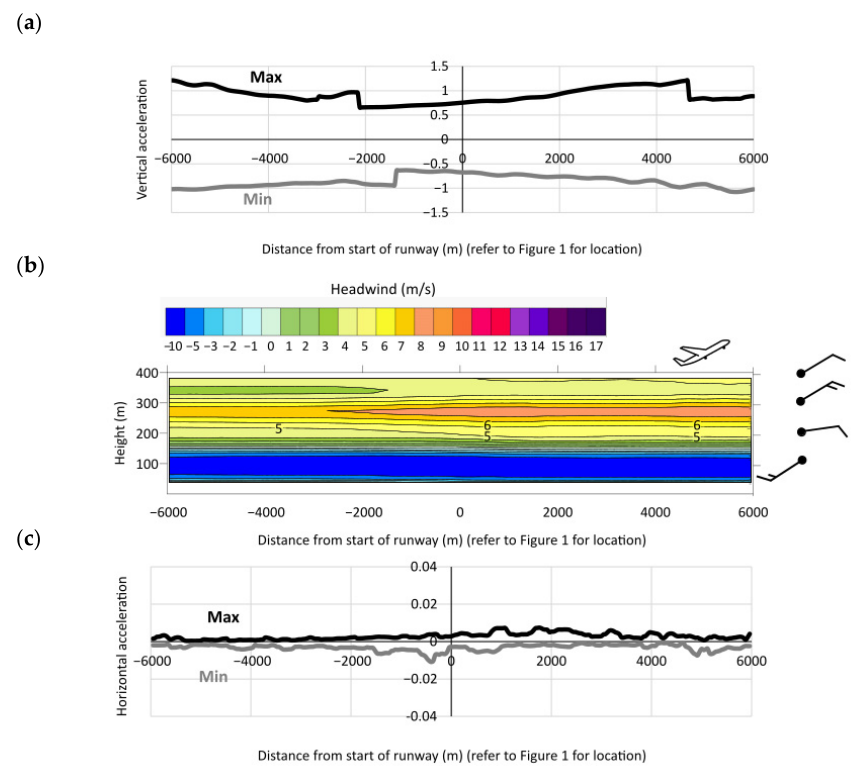
Figure 7. The main figure ( a ) shows calculated flowfield for 09:05 7 January 2018 at 100 m, with high-resolution detail corresponding approximately to the vertical output slice shown in Figure 6b. The inset ( b ) shows the observed vertical wind-speed (WS) and -direction (WD) profiles at CCH.